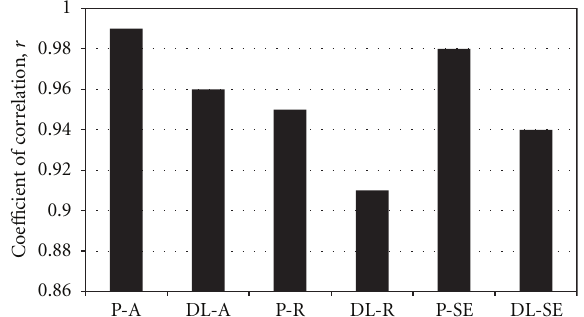
Figure 11: Coe ffi cients of correlation between dielectric and microwave properties: P: dielectric permittivity; A: attenuation; DL: dielectric loss; R: reflection, S.E.: shielding e ff